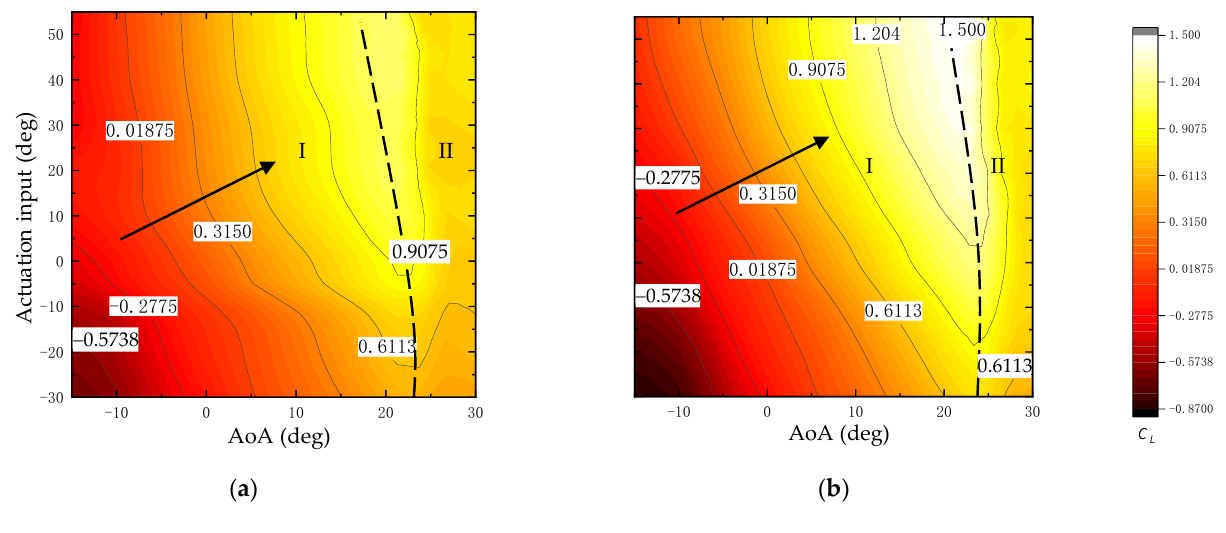
The maximum lift coefficients under each actuation input are connected by a dashed